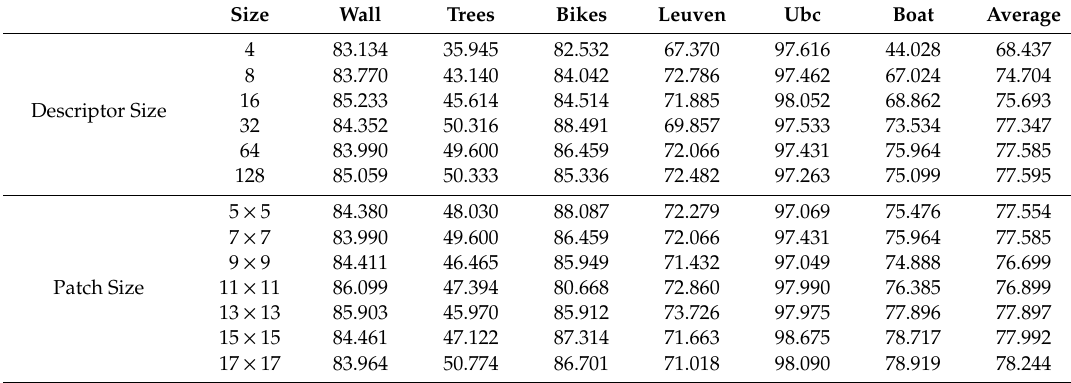
Table 3. Matching precision based on Oxford dataset with di ff erent descriptor size or patch size (%).